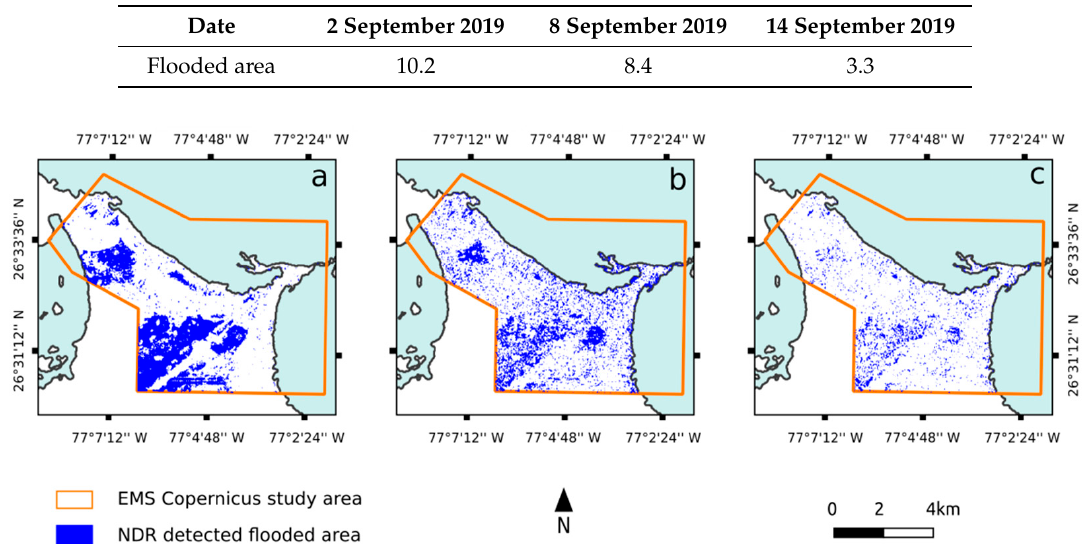
Table 5. Evolution of flooded area in Marsh Harbour between 2 and 14 September 2019. Data in square kilometers.